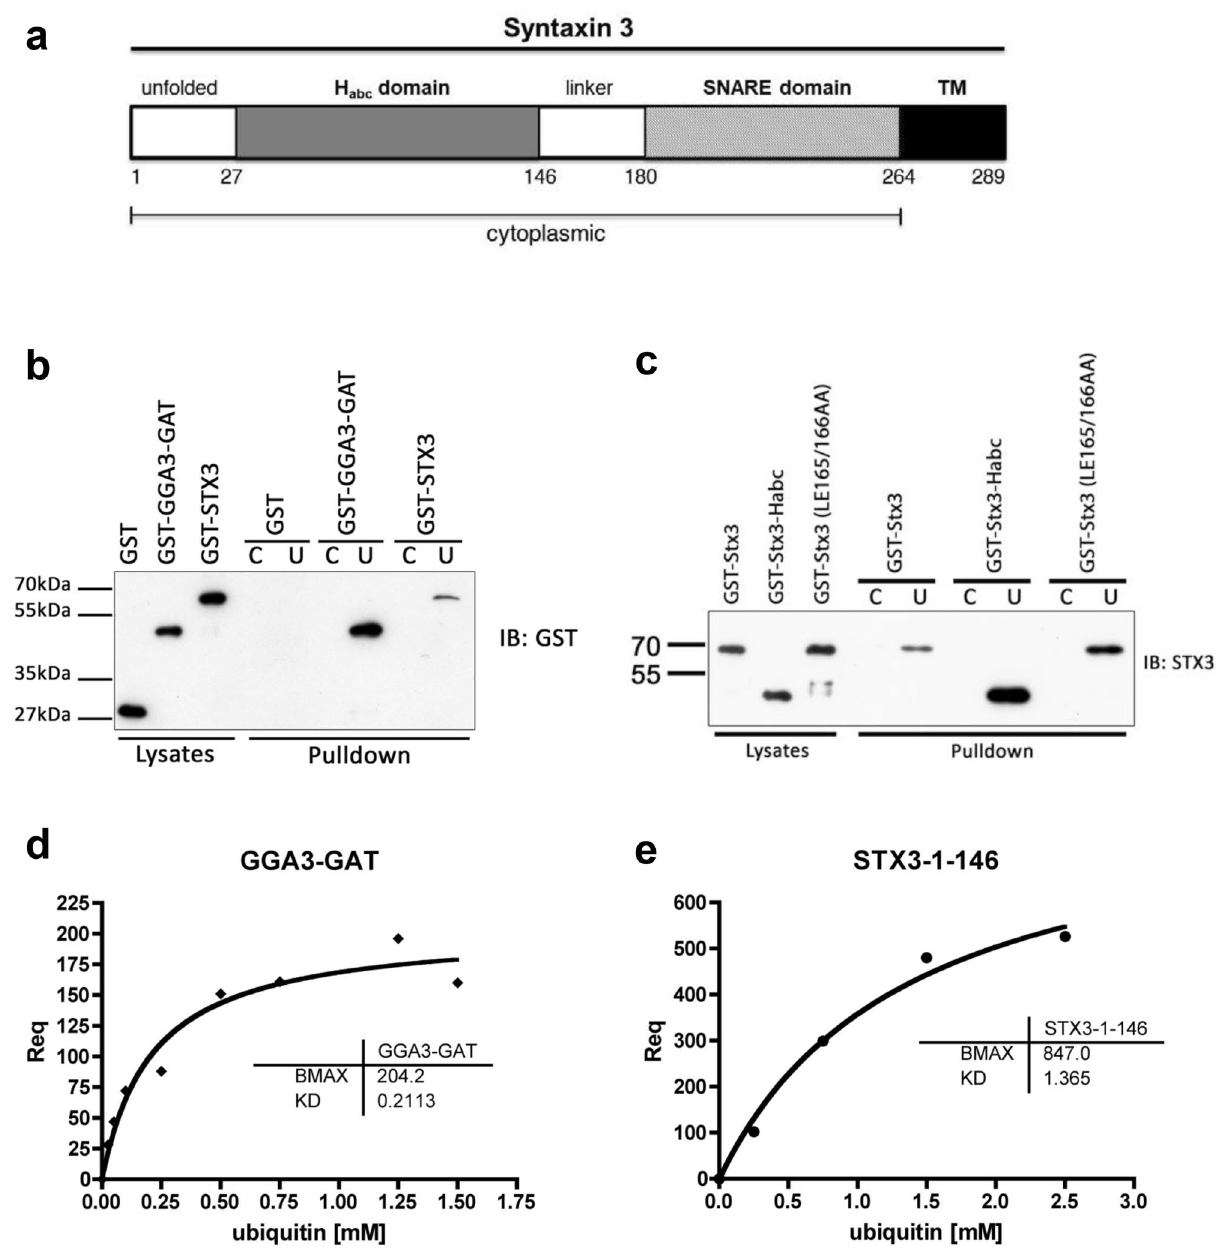
Figure 1. Stx3 binding to mono-ubiquitin. ( A ) Schematic of representation of Syntaxin 3. ( B ) Purified GST fusion protein of the GGA3-GAT domain (positive control for ubiquitin binding) or the cytoplasmic region (1–265) of Stx3 was precipitated with ubiquitin-coated (U) agarose beads or control, uncoated CL4B beads (C) and subjected to immunoblotting (IB) using anti-GST antibody. ( C ) Purified GST fusion proteins: cytoplasmic region of Stx3 (1–265), H abc domain Stx3 (1–146), and constitutively open mutant of cytoplasmic region Stx3 (L165A/E166A) were each precipitated as in panel A and probed with anti-Stx3 antibody. ( D ) SPR experimental data of interaction between captured GST-GGA3-GAT and free ubiquitin. ( E ) SPR experimental data of interaction between captured GST-Stx3-1–146 and free ubiquitin. In B, C, D and E, experiments shown are representative of three independent